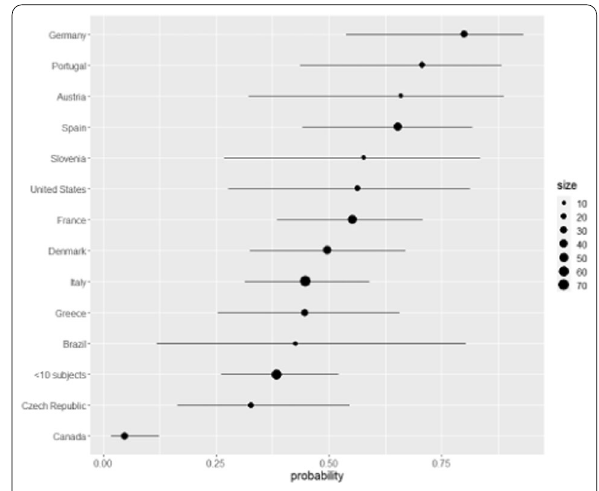
Figure 1. Caterpillar plot of the probability of ICP monitor use among countries. Predicted probability of ICP monitoring (dots) with their 95% CIs (lines) are given on the horizontal axis, and countries are reported on the ver- tical axis. The size of dots showed the number of patients enrolled in each